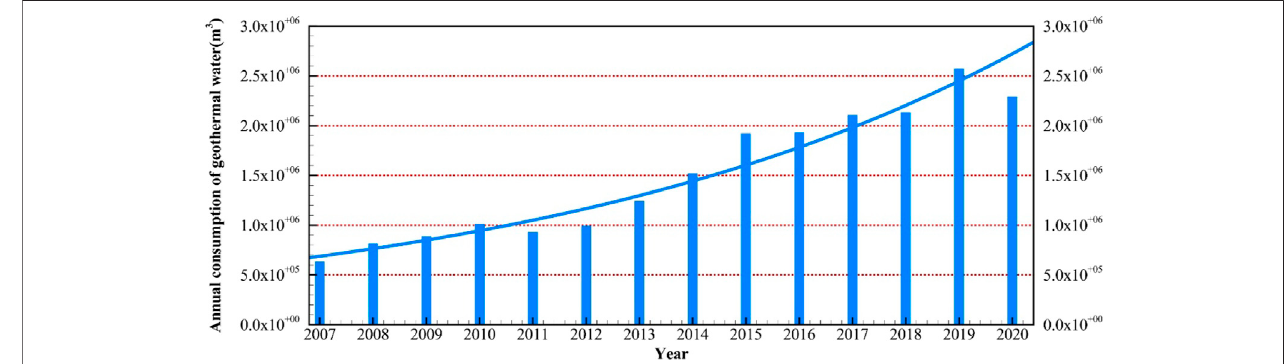
FIGURE 5 | Annually increasing consumption of geothermal water in the last 14 years.